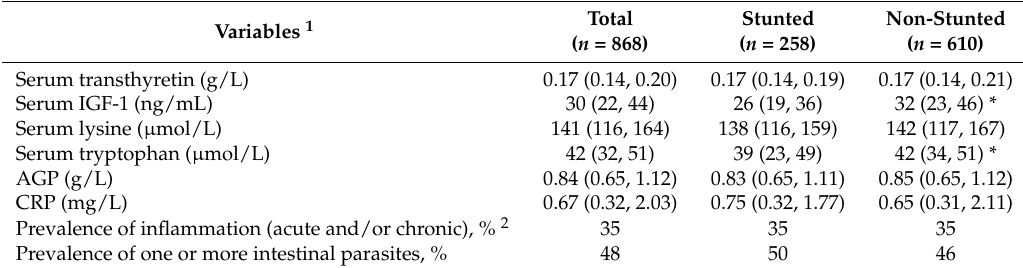
Table 4. Energy intake of children 1 .